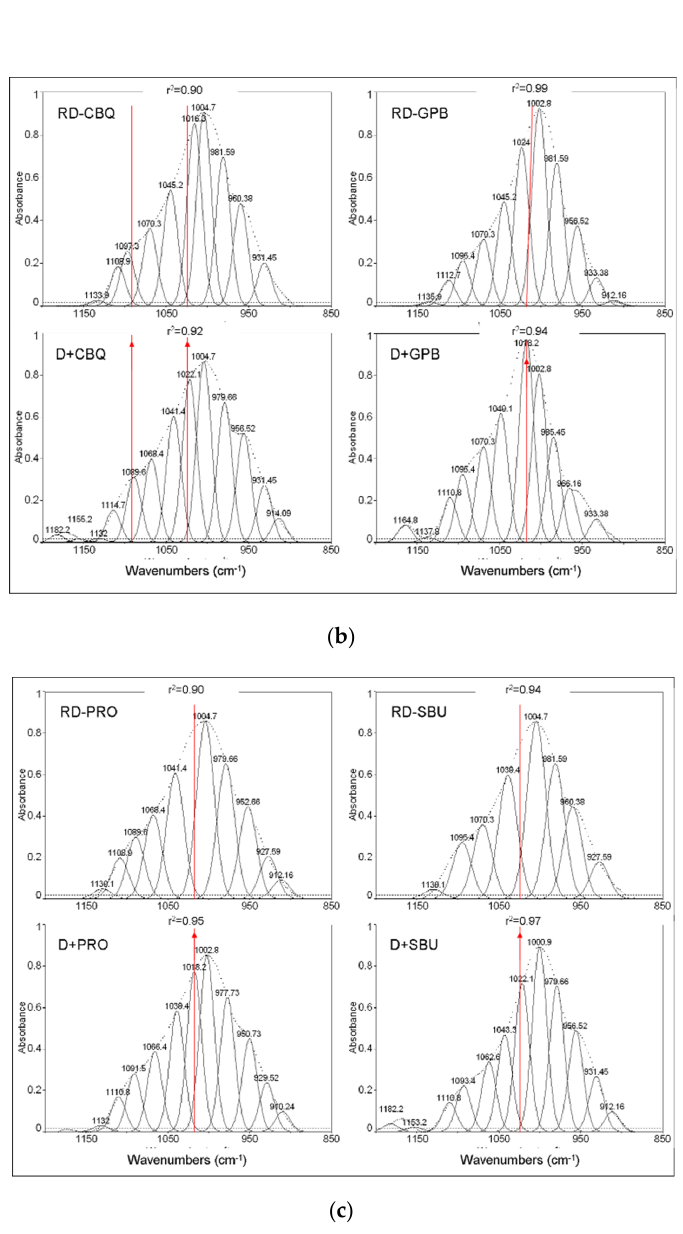
Figure 4. Gaussian curve-fitting of the complex calcium phosphate peak of reference dentin (RD) and of dentin treated with the adhesives after rinsing (RD + adhesive code) per product. The vertical lines denote the peaks appearing only on treated dentin, associated with calcium phosphates formed by the adhesive monomers (absorbance scale, 1185–885 cm − 1 wavenumber range, r 2 : goodness of fit). ( a ) ABU and ADU, ( b ) CBQ and GPB, ( c ) PRO and SUB. The results of the Weibull analysis ( β , σ 0 , 95% C.I. for σ 0 , σ 0.1 and 95% C.I. for σ 0.1 ) are listed in Table 4. The ranking of the materials in reliability ( β ), from highest to lowest, was CBQ, SBU, PRO, ADU, GPB, ABU, with no statistically significant difference between them (p > 0.05). For the characteristic life ( σ 0 ), the ranking of the statistically significant differences was CBQ, ADU, ABU, SBU > PRO > GPB (p < 0.05), whereas for the 10% failure probability ( σ 0.1 ) SBU demonstrated the highest values with no statistically significant differences from CBQ, ADU, ABU, PRO and GPB the lowest, with no statistically significant differences from ADU, ABU, PRO. The σ 0.1 / σ 0 ratios expressed in percentage were 67% (ABU, GPB), 68% (ADU), 74% (SBU, PRO) and 76% (CBQ). All failures were